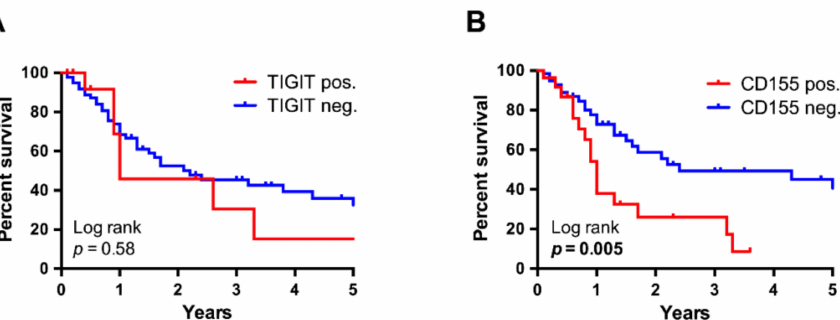
Figure 7. Kaplan-Meier survival analysis, stratified for TIGIT- and CD155 positivity. While the survival curves of cases with and without TIGIT + immune cells followed a similar trend ( n = 103) ( A ), CD155 positivity was associated with a significantly worse survival by log-rank testing ( n = 95, p = 0.005, 1.0 vs. 2.4 years) ( B